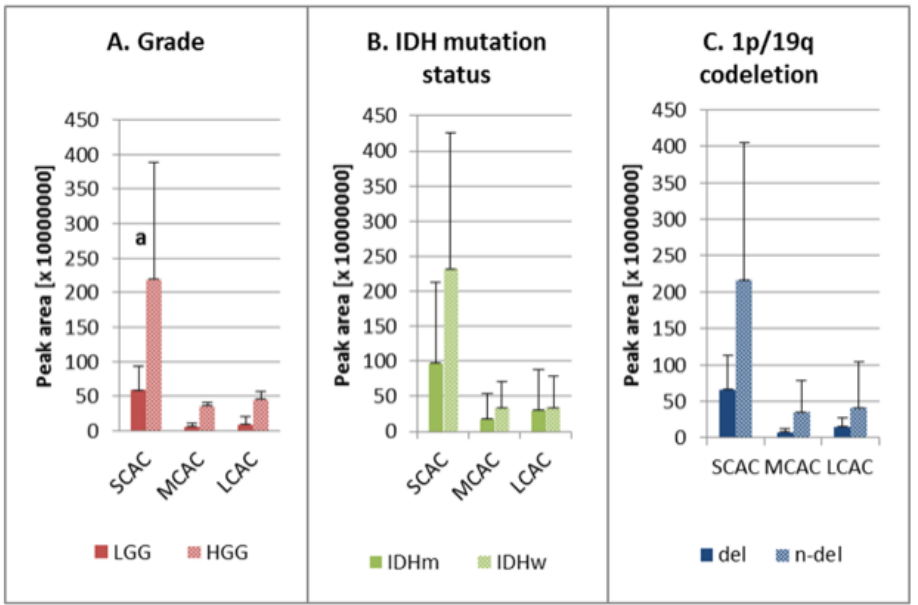
Figure 2. Ratios of SCAC, MCAC, and LCAC in the studied groups: ( A ) low-grade (LGG) and high-grade glioma (HGG); ( B ) IDH mutation status — IDH mutant (IDHm) and IDH wild-type (IDHw); ( C ) 1p/19q co-deletion — presence of deletion (del) and absence of deletion (n-del). AC — acylcarnitine; del — presence of 1p/19q co-deletion; HGG — high-grade glioma; IDHm — IDH mutation, IDHw — IDH wild-type; LCAC — long-chain-length acylcarnitine; LGG — low-grade glioma; MCAC — medium-chain-length acylcarnitines; n-del — absence of 1p/19q co-deletion; SCAC — short-chain-length acylcarnitines; a the average peak area for HGG is statistically significantly different from LGG, p < 0.05.